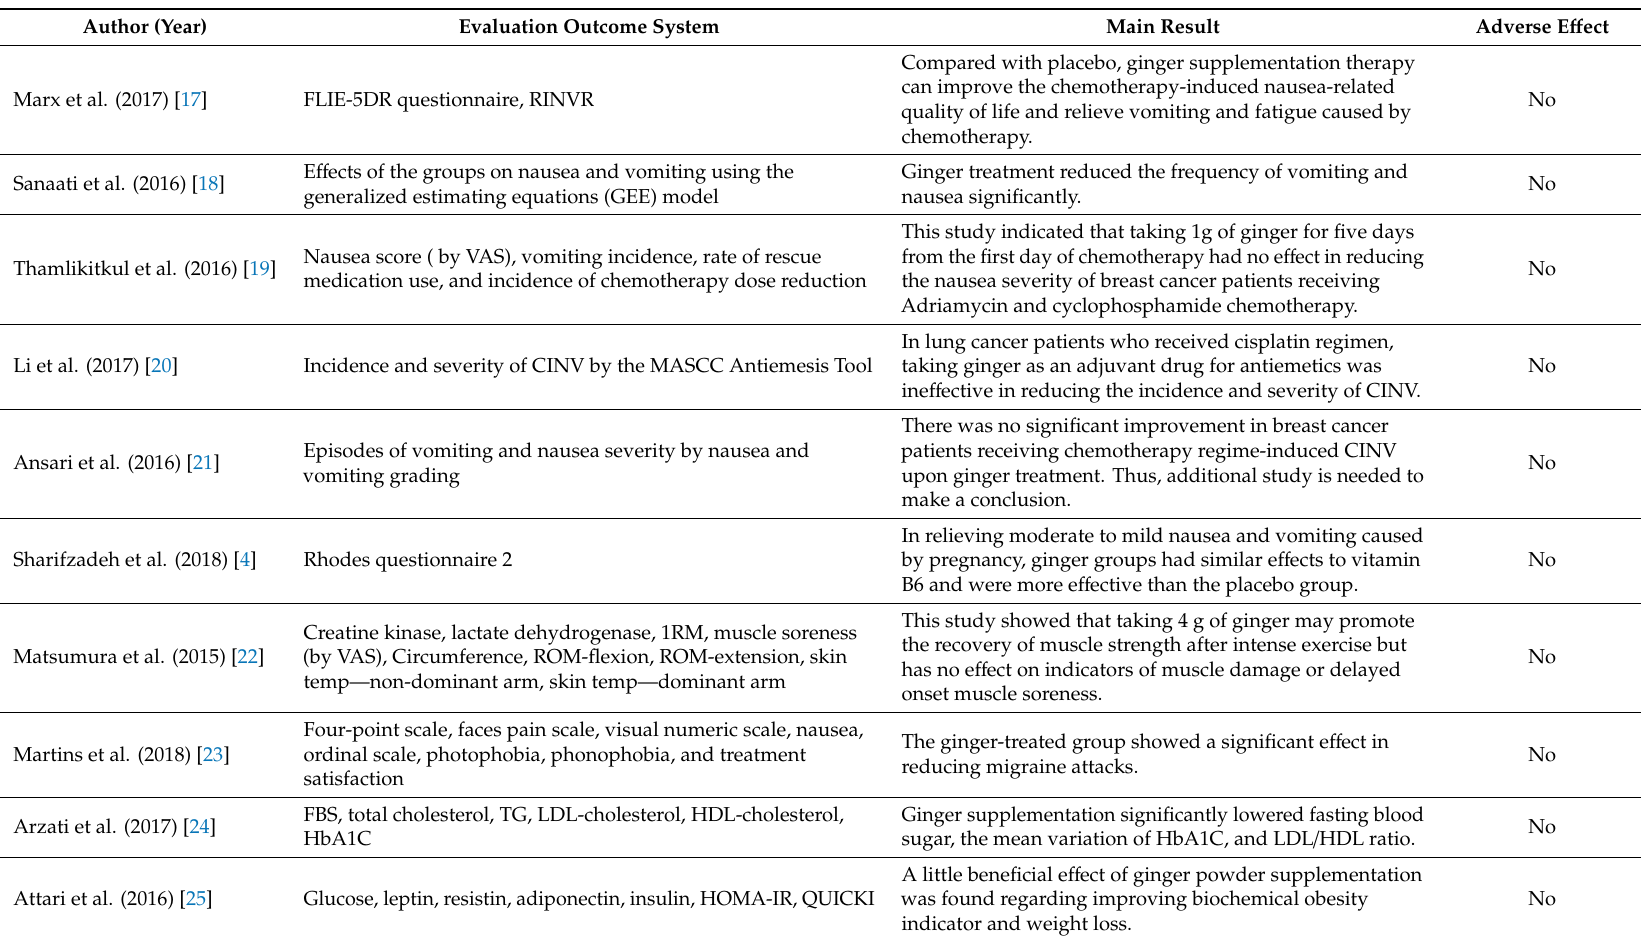
Table 2. Evaluation system and key finding of the included studies with a “high quality of evidence” (quality assessment score is of at least